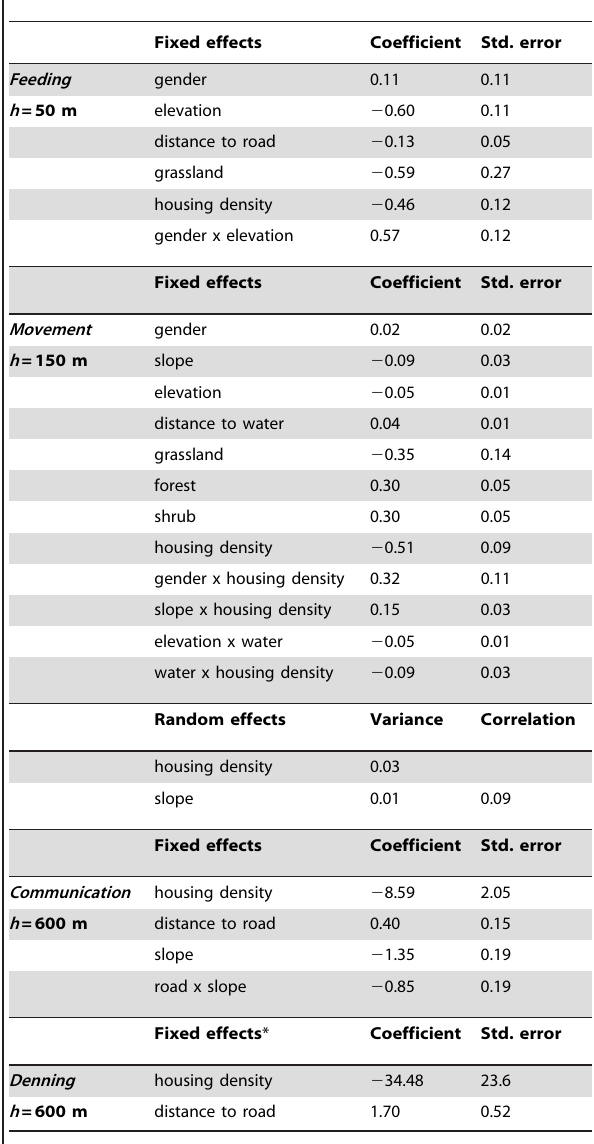
Table 1. The best fit RSF model for each puma behavioral category (in